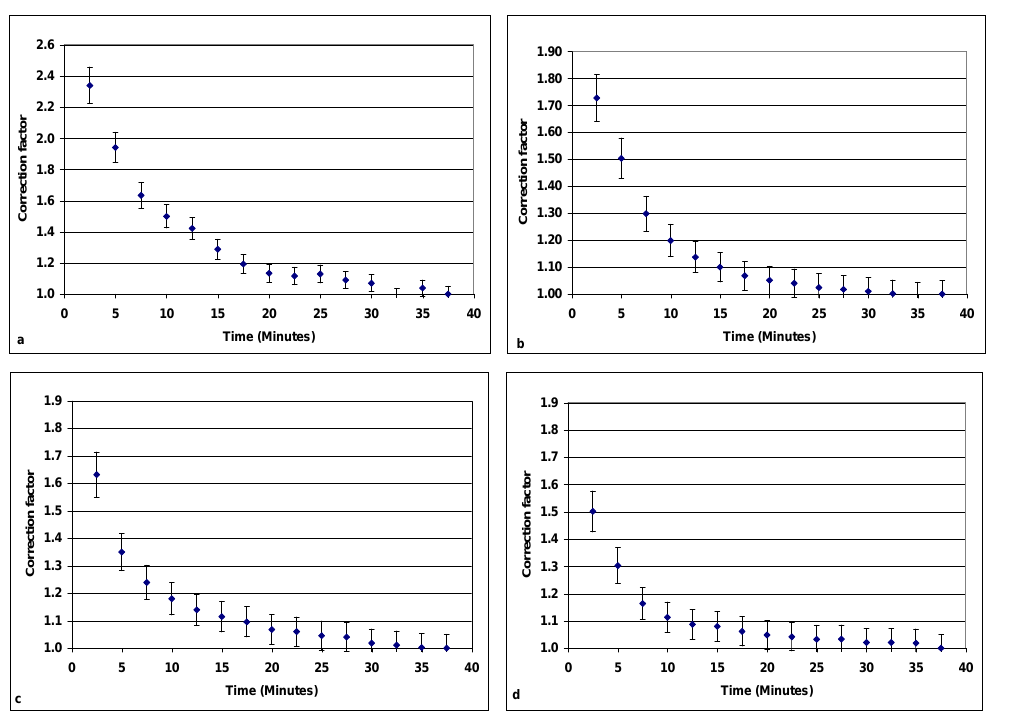
Figure 4. Correction factors with respect to time period in each location (a) = 0.8 ppm; (b) = 6.2 ppm; (c) = 9.7 ppm and (d) = 13.7